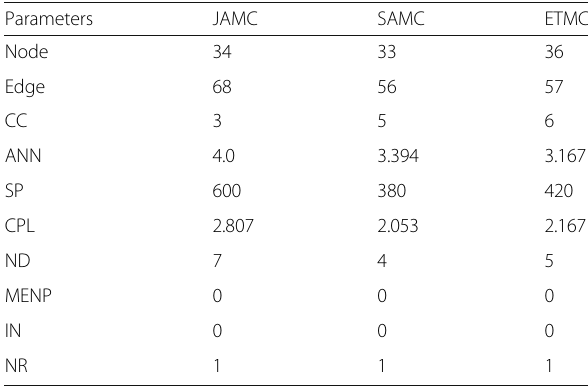
Table 6 Values of topological